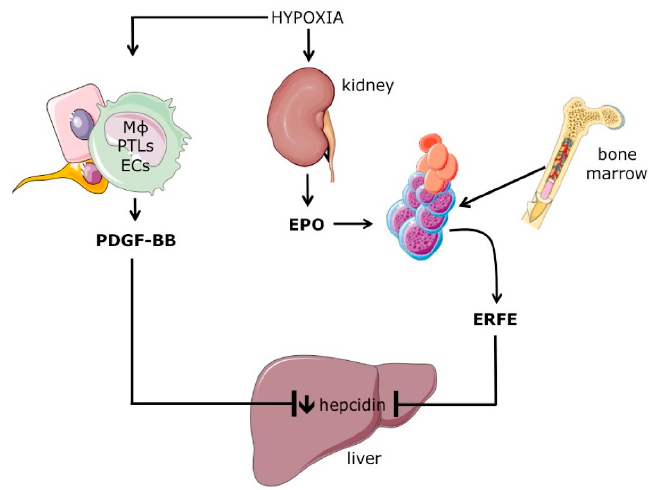
Figure 4. Mechanisms of hepcidin inhibition by increased erythropoiesis. Systemic hypoxia increases erythropoietin (EPO) production by the kidney. EPO, by stimulating erythroid cell proliferation and differentiation, also increases the expression the Erythroferrone (ERFE), a secreted protein that inhibits the expression of hepcidin by hepatocytes by sequestering BMP ligands. Hy- poxia is also sensed by other cells, such as macrophages (M Φ ), platelets (PTLs), and endothelial cells (ECs), that increase the production of serum platelet-derived growth factor-BB (PDGF-BB), which contributes to hepcidin downregulation. Adapted with permission from Ref. [6]. License date: 15 February 2023; Elsevier. Erfe is upregulated in erythroid tissues in all conditions characterized by increased serum EPO and expanded erythropoiesis, such as iron deficiency anemia and hypoxia [80], but also in diseases characterized by ineffective erythropoiesis, such as be- ta-thalassemia [82]. Here, excessive ERFE production causes secondary iron overload, as also observed in mice overexpressing Erfe [83]. However, preclinical models demonstrate that ERFE is relevant in hepcidin downregulation in conditions of acute stress erythro- poiesis, but not in chronic conditions [84], where other mechanism/s are likely involved. For example, platelet-derived growth factor-BB (PDGF-BB), a secreted protein released by endothelial cells, macrophages, and platelets in response to hypoxia, may contribute to hepcidin downregulation [85] (Figure 4). 7. Concluding Remarks In recent years, significant advances in understanding how iron homeostasis is reg- ulated and the clinical implications of its deregulation have been attained. Nevertheless, several questions still need to be answered. Understanding the detailed molecular mechanisms of BMP-SMAD pathway regulation by plasma and tissue iron and how the hepatocyte responds to a combination of different signals will increase our understand- ing of how systemic iron homeostasis is maintained in physiological conditions and how